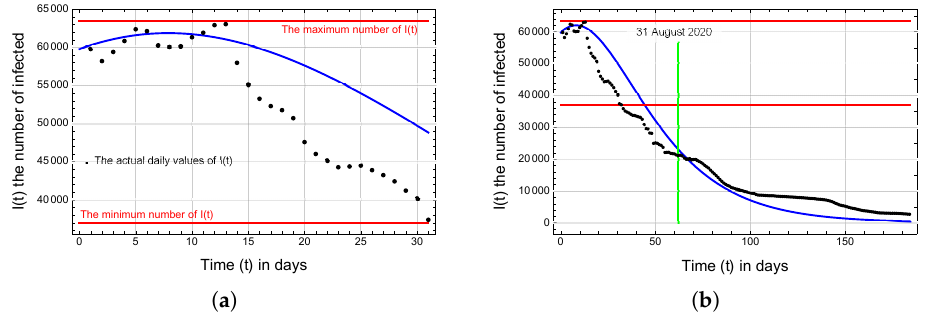
Figure 6. The behavior of the daily infected active cases due to parameter determined from the data of July. ( a ) Calculated and actual daily infected active cases along small period of time (July). ( b ) Calculated and actual daily infected active cases along long period of time (from July to end of 2020).